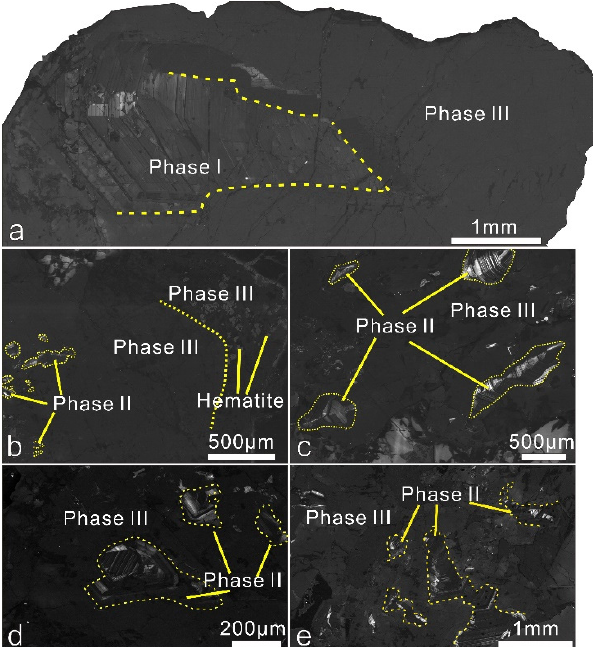
Figure 2. CL images of zircon megacrysts from pegmatite, showing different phases (from I to III) of zircon. ( a – e ) Phase I represents zoned igneous zircon. Phase II zircons have an oscillatory zonation similar to Phase I, but a different trace elements content. Phase III represent unzoned zircon with a high Th and REE content and contain abundant hematite inclusions.